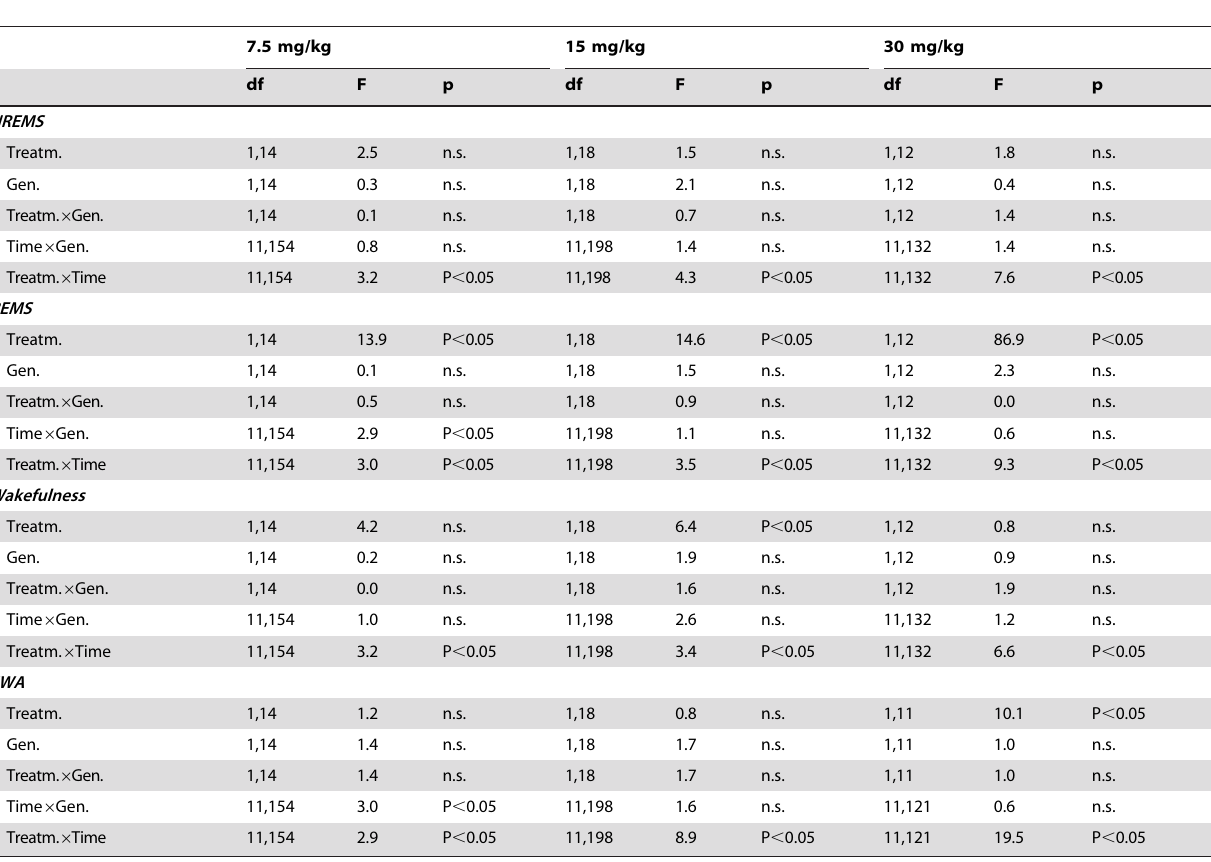
Table 1. The effects of C75 on sleep, wakefulness and slow-wave activity (SWA) of the electroencephalogram: statistical